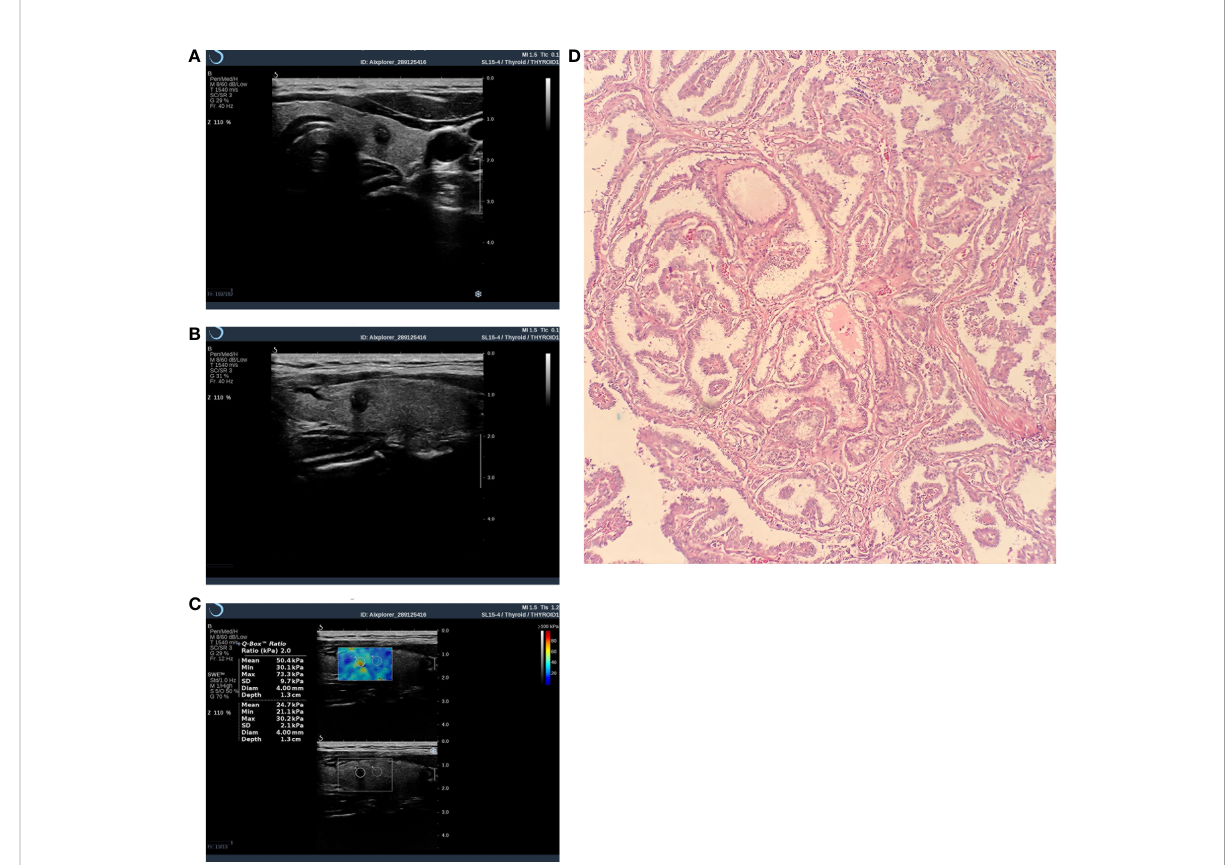
FIGURE 3 Thyroid nodule image of a 43-year-old female patient. It was diagnosed as malignant by C-TIRADS and SWE. (A) Crosscut two-dimensional ultrasound with a C-TIRADS rating of 4c. (B) Longitudinally cut two-dimensional ultrasound. (C) SWE image, Emax=73.3kpa. (D) Pathological image(HE×100),Postoperative histopathological examination showed papillary thyroid